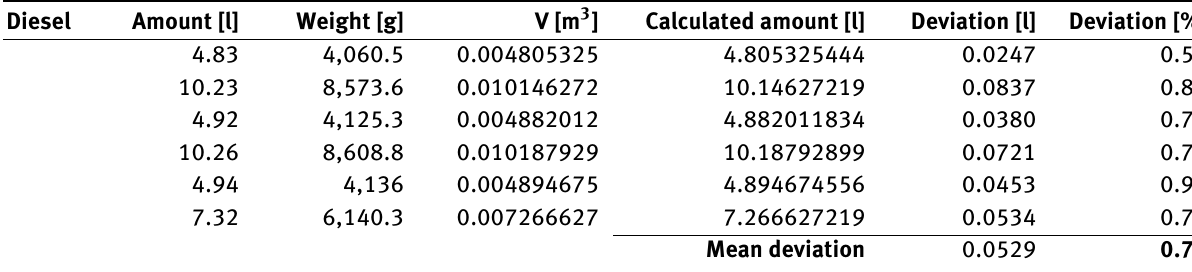
Table 4: Accuracy of amounts of dispensed fuel – diesel Diesel Amount